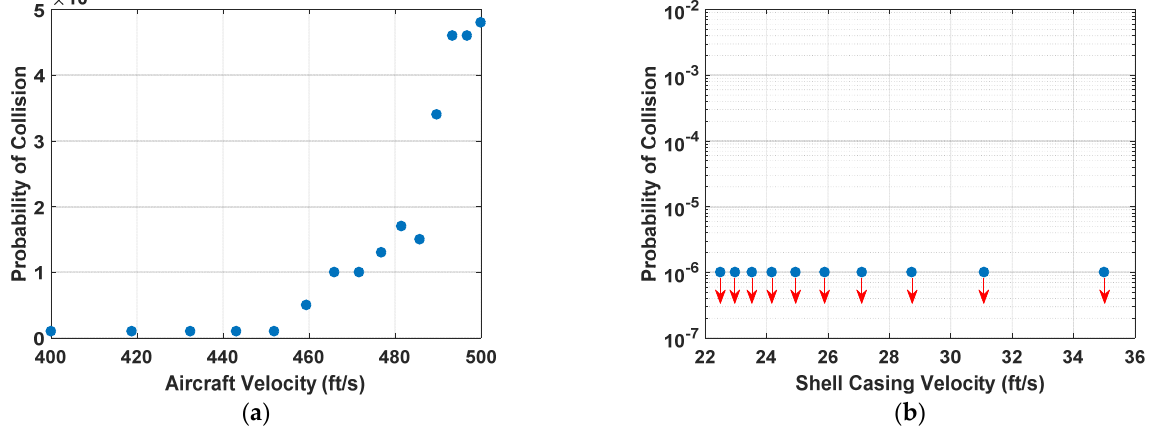
Figure 14. Effects of ( a ) aircraft velocity and ( b ) initial velocity of shell case on POC for two ‐ seater fighter.